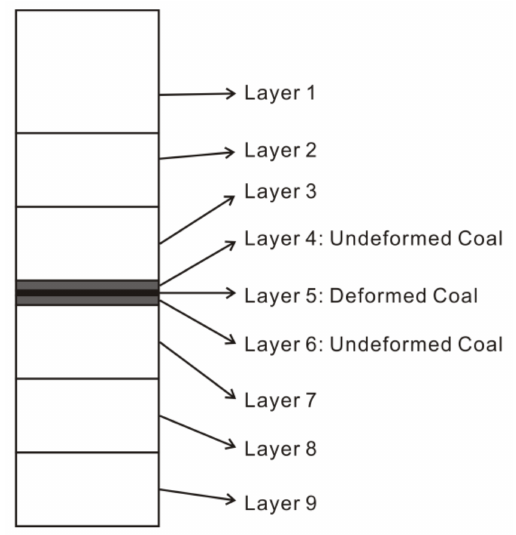
Figure 4. Theoretical model of the coal-bearing strata.